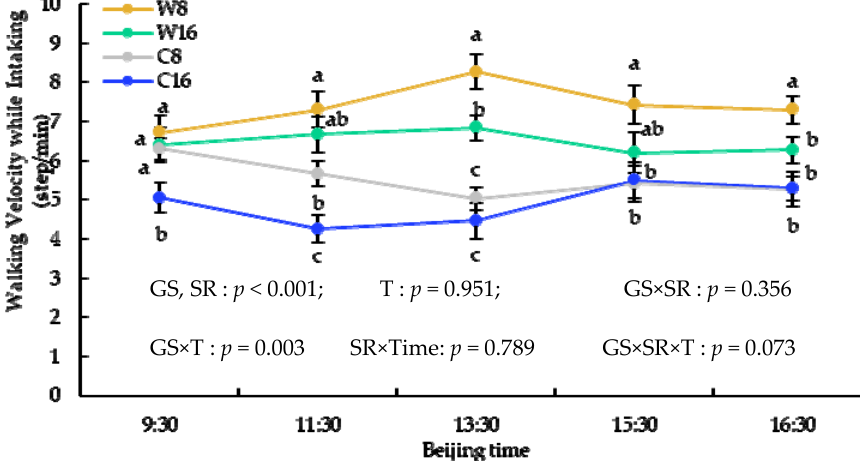
Figure 5. The x–axis is the time of day, and the y–axis is walking velocity while intaking. GS = grazing season; SR = stocking rate; T = times.